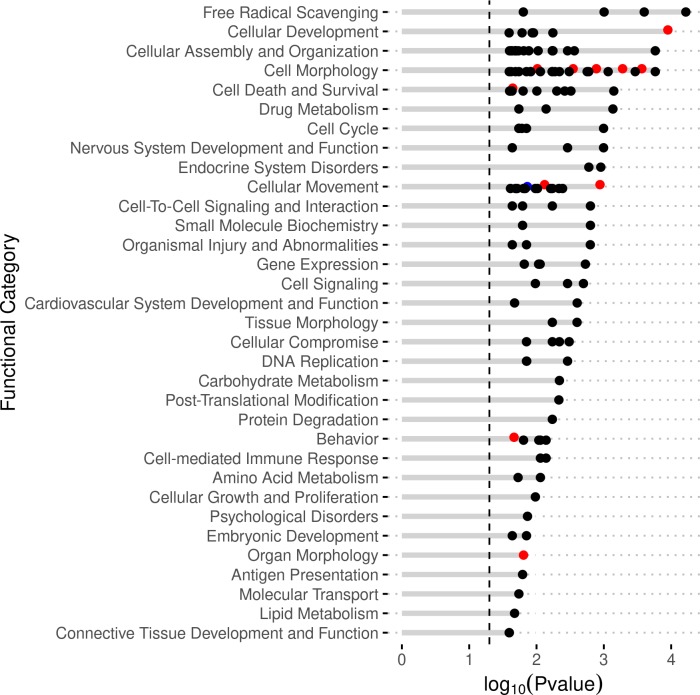
IPA disease and function analysis of DEGs.The enriched functions are given on the y-axis. The x-axis represents the significance (negative Log of P-value). The color of the dots indicated level of significant z-score: black: |z|<1.96, red/activated: z>1.96, blue/inhibited: z<1.96.